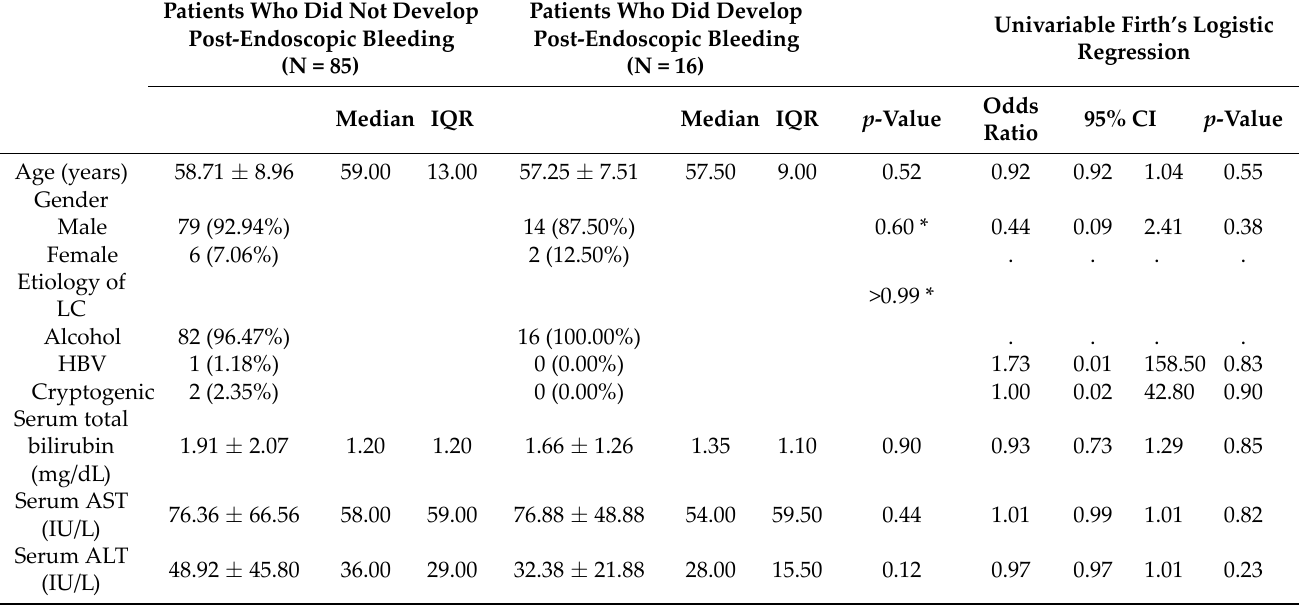
Table 2. Clinical characteristics of patients with LC who underwent endoscopic